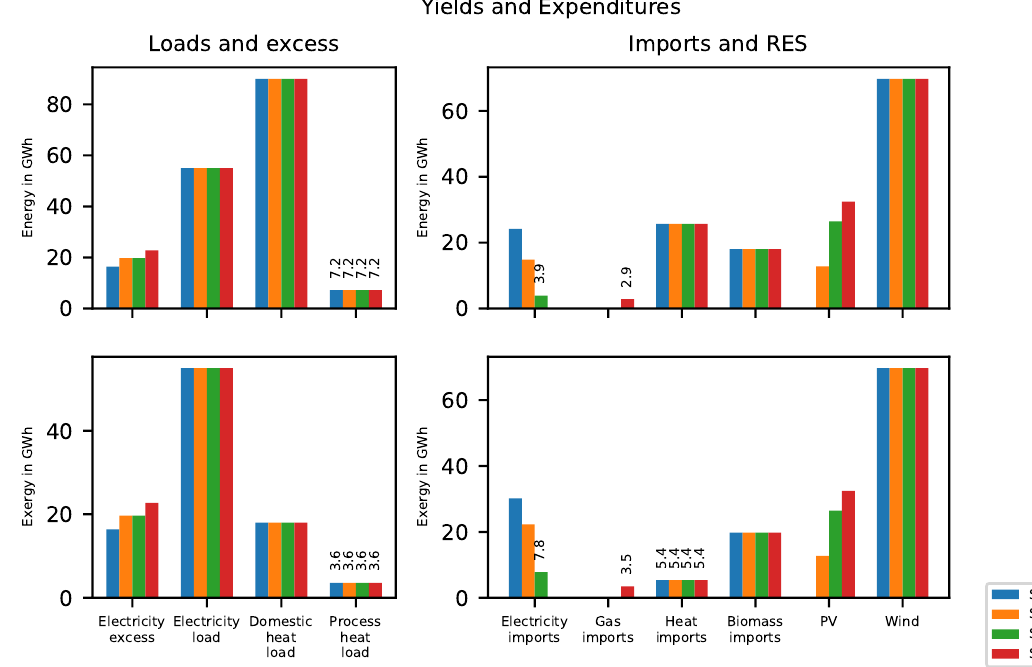
Figure 11. Energy sources and energy load, and the corresponding CExC, exergy load and excess exergy. (Source: own